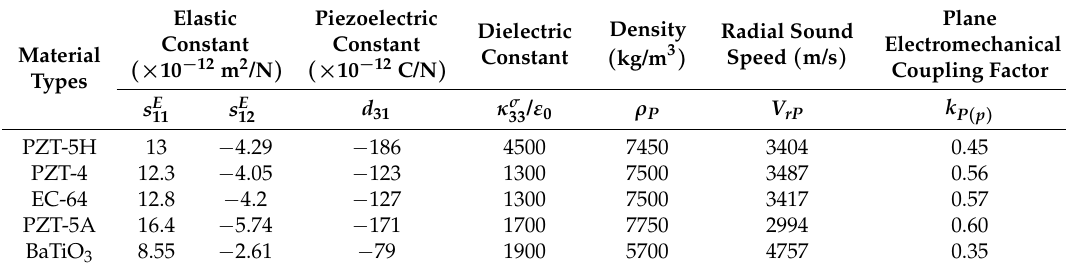
Table 1. Material parameters of piezoceramic materials [52,56–58].